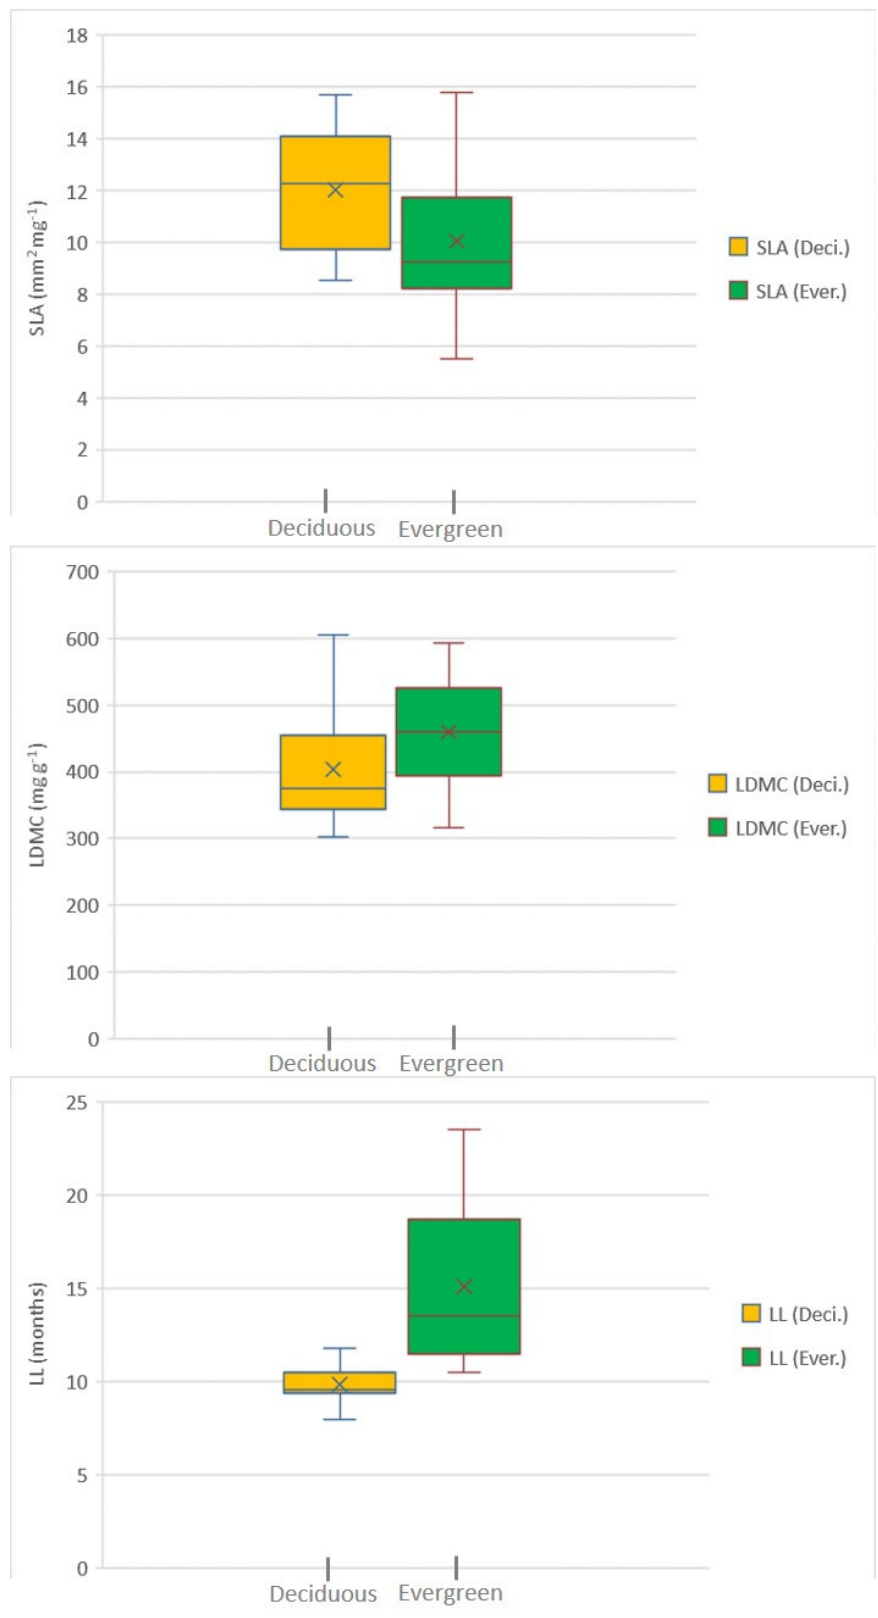
Figure 2. SLA, LDMC, and LL of evergreen and deciduous trees in tropical dry evergreen forests of peninsular India.